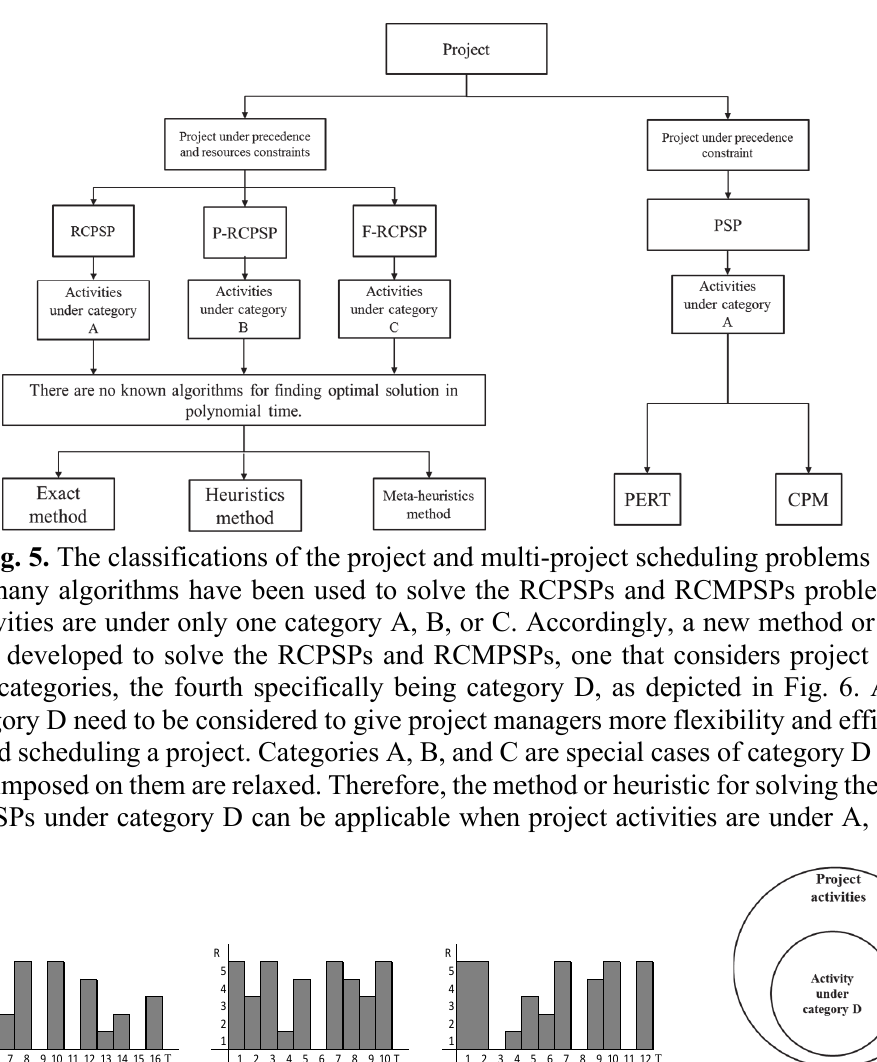
Fig. 6. An activity classified under category D